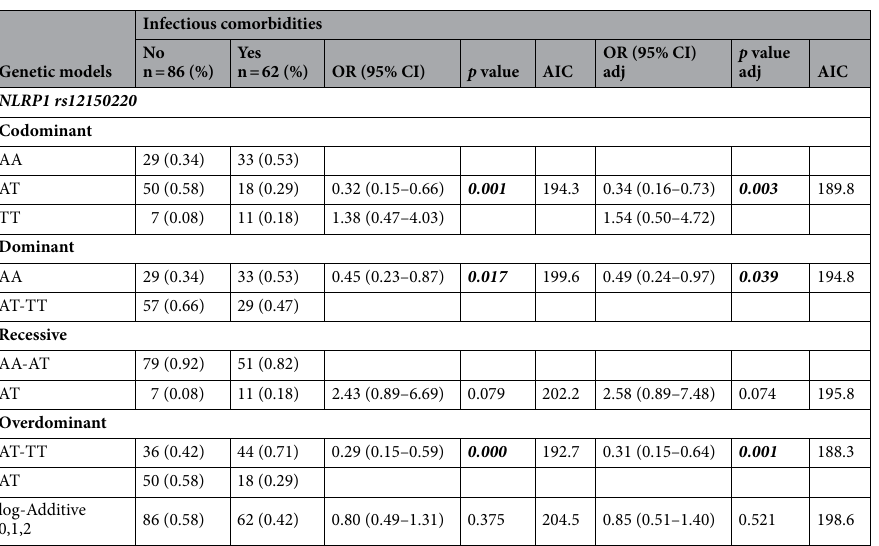
Table 3. Multivariate analysis adjusted for sex and age for the association of single-variant polymorphisms (SNVs) in study with infectious comorbidities in acute lymphoblastic leukemia patients. Adjusted for sex and age ( p value adj , OR adj ); OR: Odds Ratio; p value: < 0.05; 95% confidence interval; AIC: Akaike information criterion